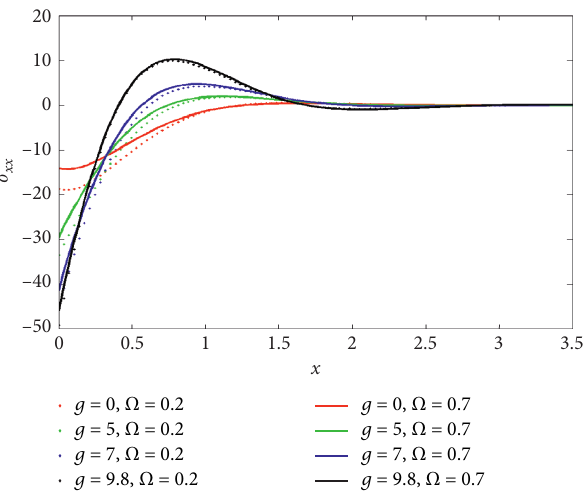
Figure 15: Stress τ x under gravity and rotation. zz concerning